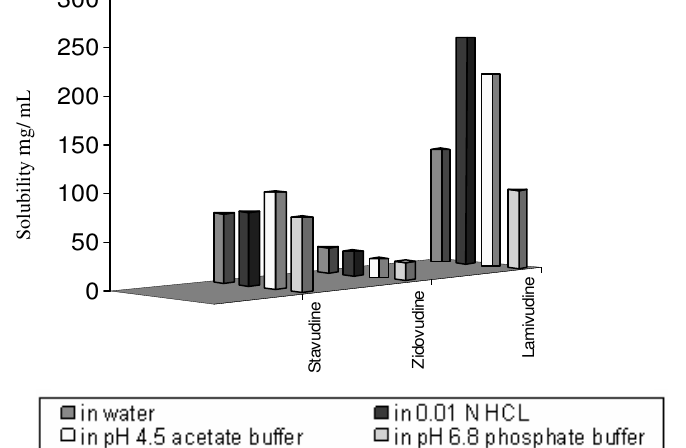
Figure 1. Solubility data of lamivudine, zidovudine and stavudine in various pH media Table 1 . Solubility of lamivudine, zidovudine and stavudine in various pH media